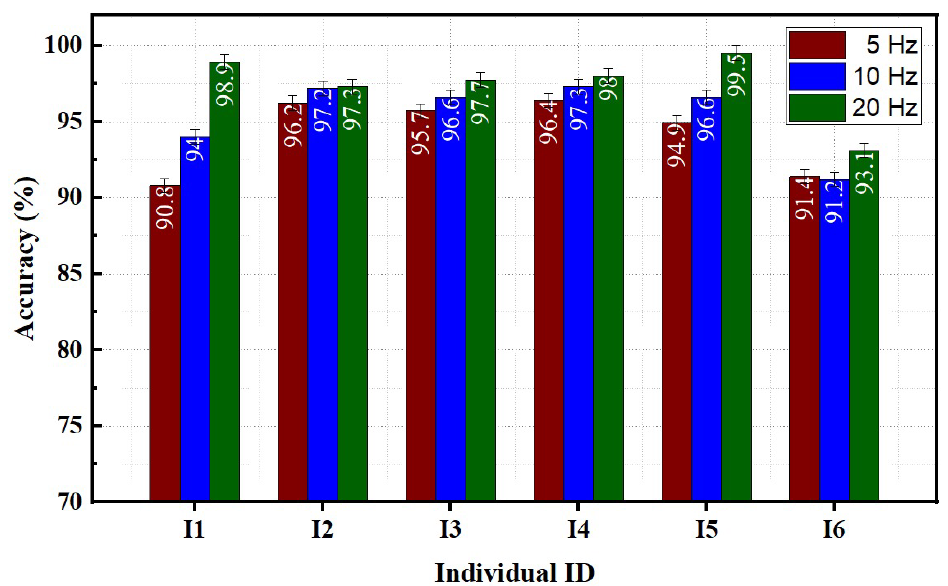
Figure 7. Effect of sampling rates on individual performance.